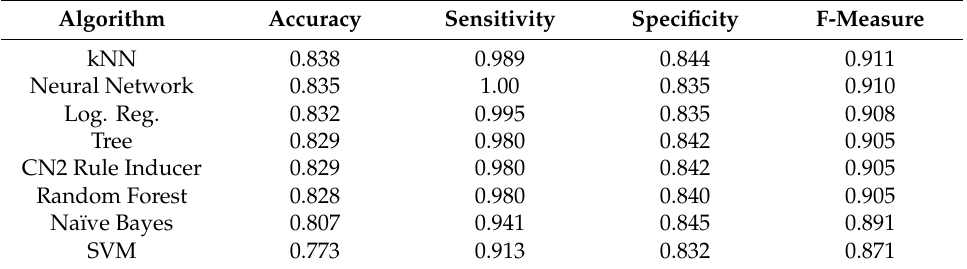
Table 8. Data transformation (equal width), feature selection (Gini decrease).